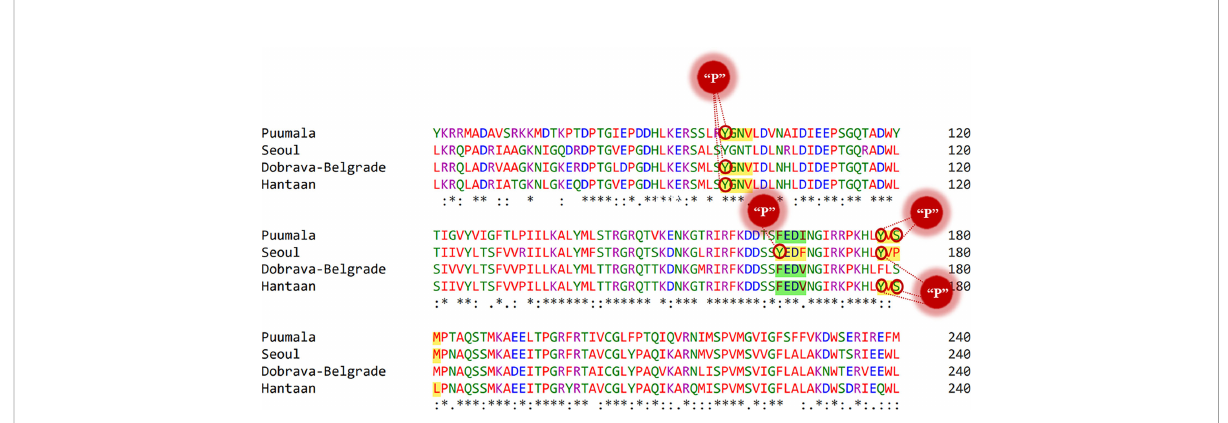
FIGURE 6 Representation of phosphorylated amino acids within the YXX F [I/L/M/F/V] motifs of viral sequences. Stars, amino acid sequence similarity; colons, amino acid sequence difference.